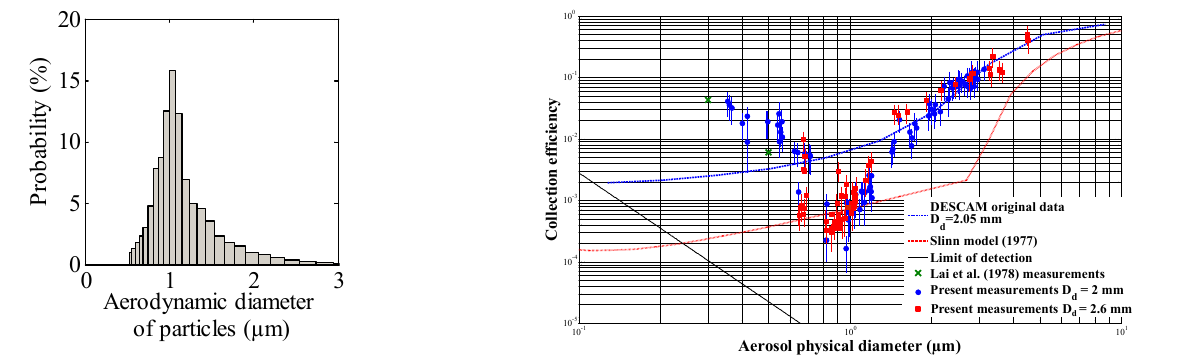
Figure 1. Characteristic size distribution of aerosol particles measured in the aerosol chamber, Figure 5. Characteristic size distribution of aerosol particles mea- Figure 6. Collection efficiencies measured in the BERGAME ex- with the Aerodynamic Particle Sizer sured in the aerosol chamber, with the Aerodynamic Particle Sizer. Figure 1. Collection efficiencies measured in the BERGAME experiment for 2 mm and 2.6 mm periment for 2 and 2.6mm drop diameter as a function of particle as a function of particle diameter